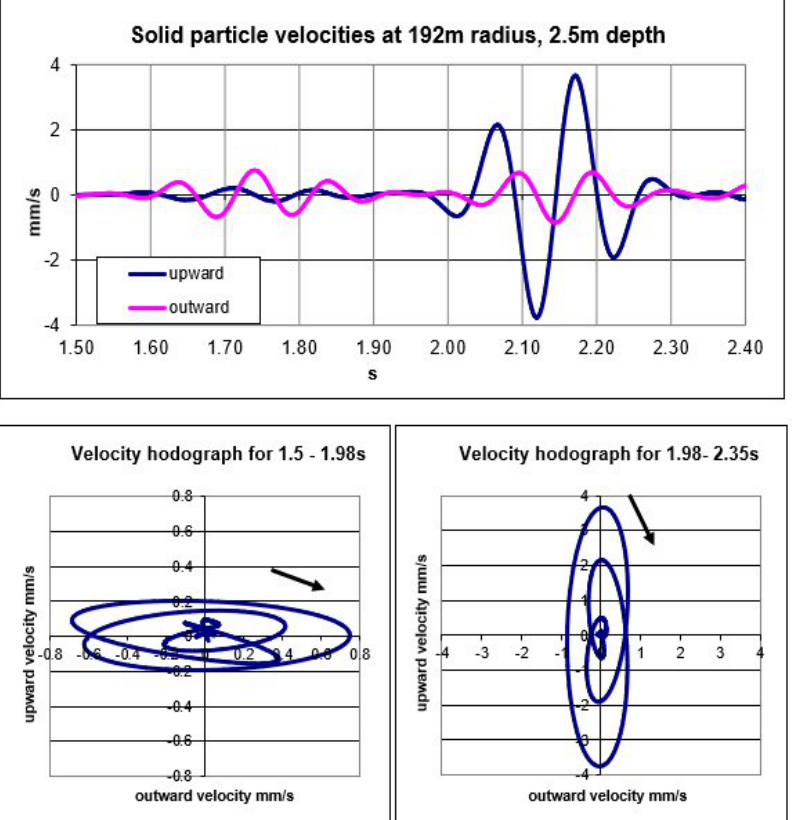
Figure 10. At greater depths, such as 2.5 m below the interface, both modes became